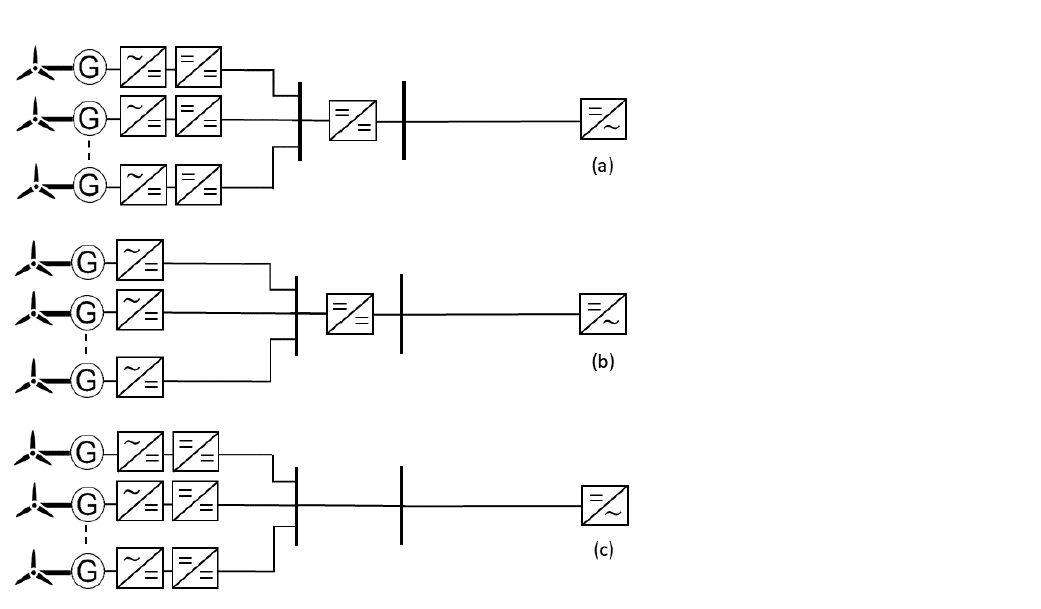
Figure 6. Different voltage step-up configurations for DC collection systems with parallel-connected WTs. ( a ) Two stages. ( b ) Single centralised stage. ( c ) Single decentralised